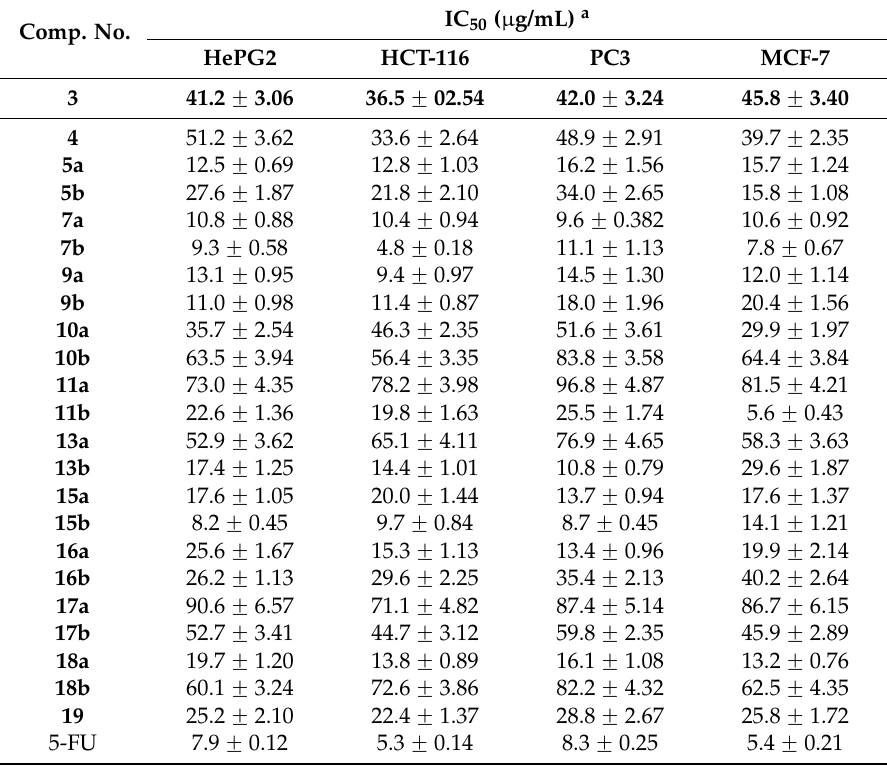
Table 1. Cytotoxicity (IC 50 ) of the tested compounds on different cell lines. Comp.